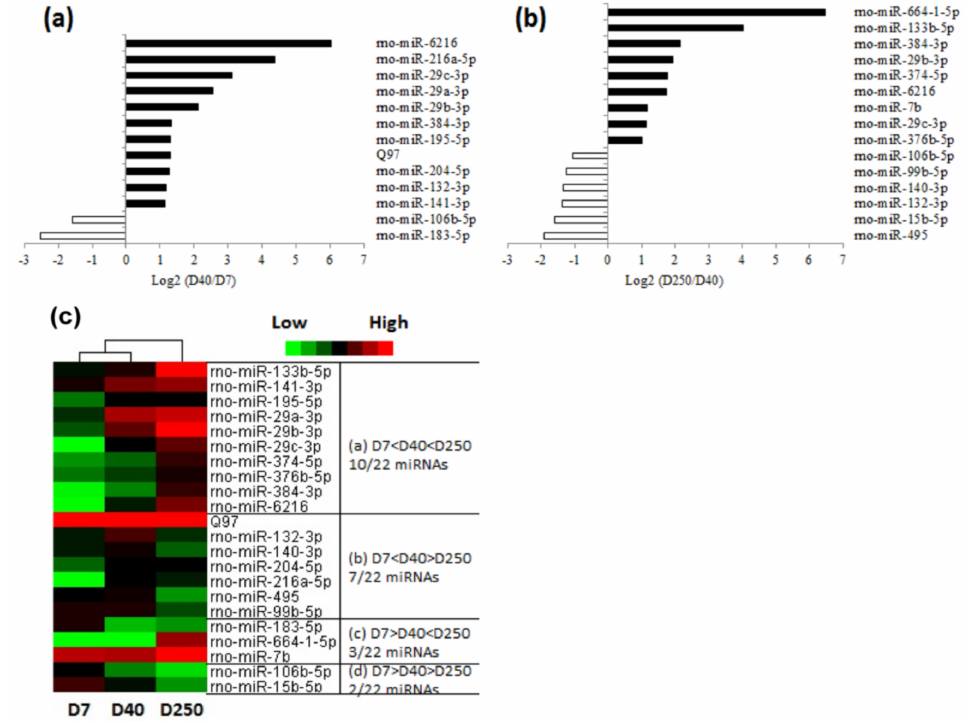
Figure 2. The comparisons and heat map of the differentially expressed microRNAs (miRNAs) among the different ages. ( a ) Differentially expressed miRNAs between Day 7 and Day 40. ( b ) Differentially expressed miRNA between Day 250 and Day 40. Results were reported as fold change in specific miRNA expression. Each bar corresponds to the expression fold difference, calculated as log 2 [(D40 signal)/(D7 signal)] or log 2 [(D250 signal)/(D40 signal)], of miRNA listed in the figure. The fold change is over 2. ( c ) Heat map of the differentially expressed miRNAs. Each row represents the relative level of expression of a single miRNA, and each column indicates the expression levels for a single sample. The red or green color indicates relatively high or low expression,